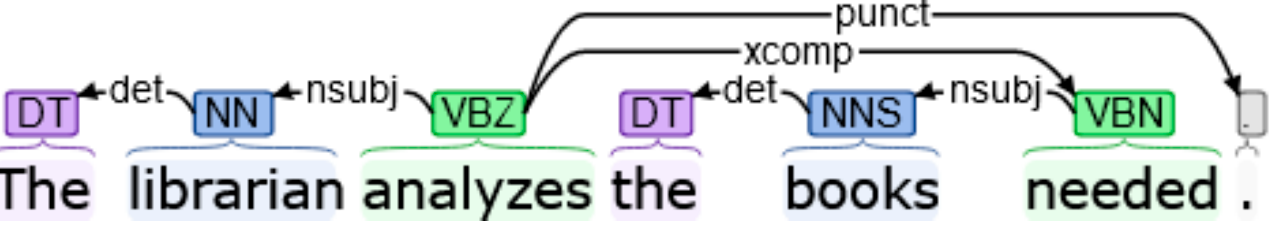
Figure 3. Dependency parsing of simple sentence. The sentence structure consists of a noun (NN), a verb (VBZ), and an object. The ID2SBVR determines the fact type candidate based on triplet extraction using Algorithm